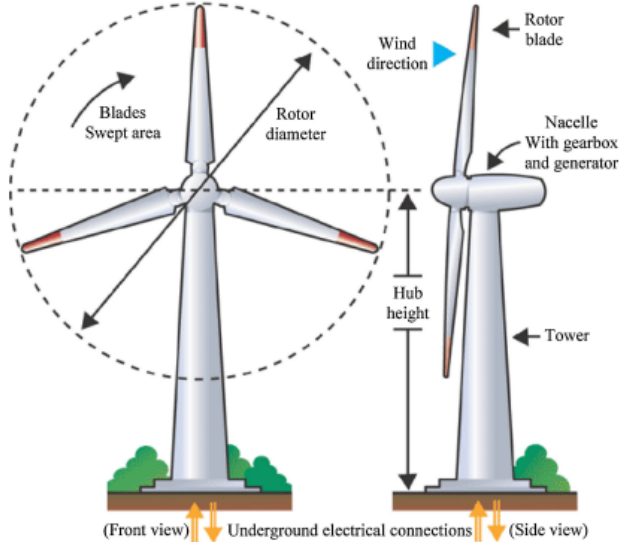
Figure 1. Wind turbine: front view and side view [14].